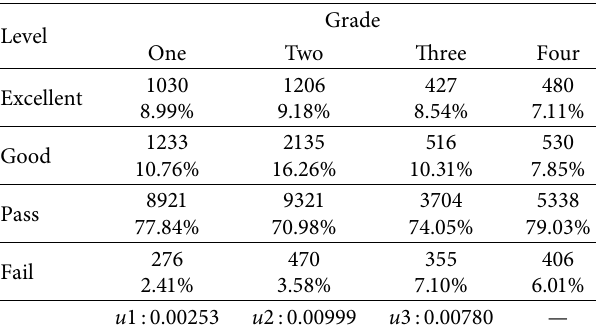
Table 7: Boys’ trunk forward bending scores and grade